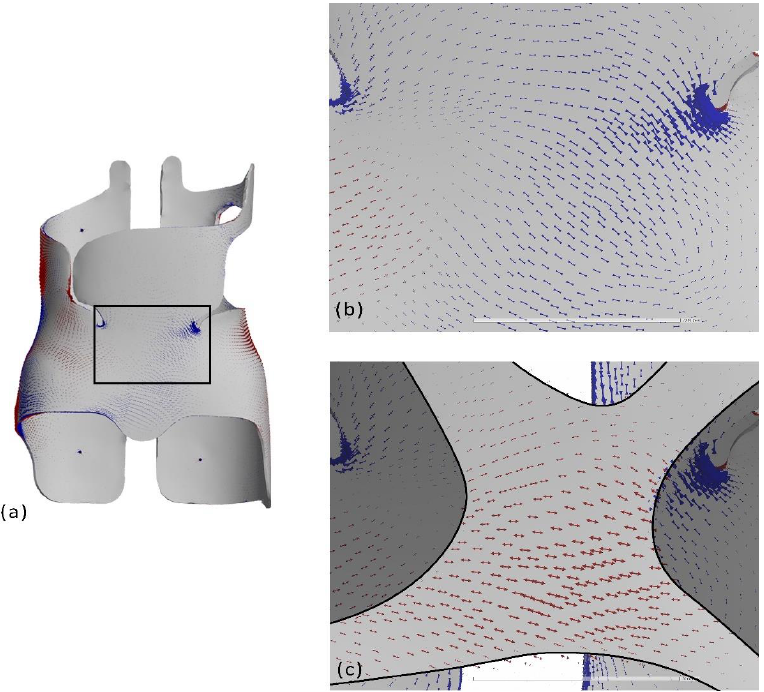
Figure 7. View of orthosis with values of von Mises stress: ( a ) left side—front from exterior, ( b ) right side—front from interior.